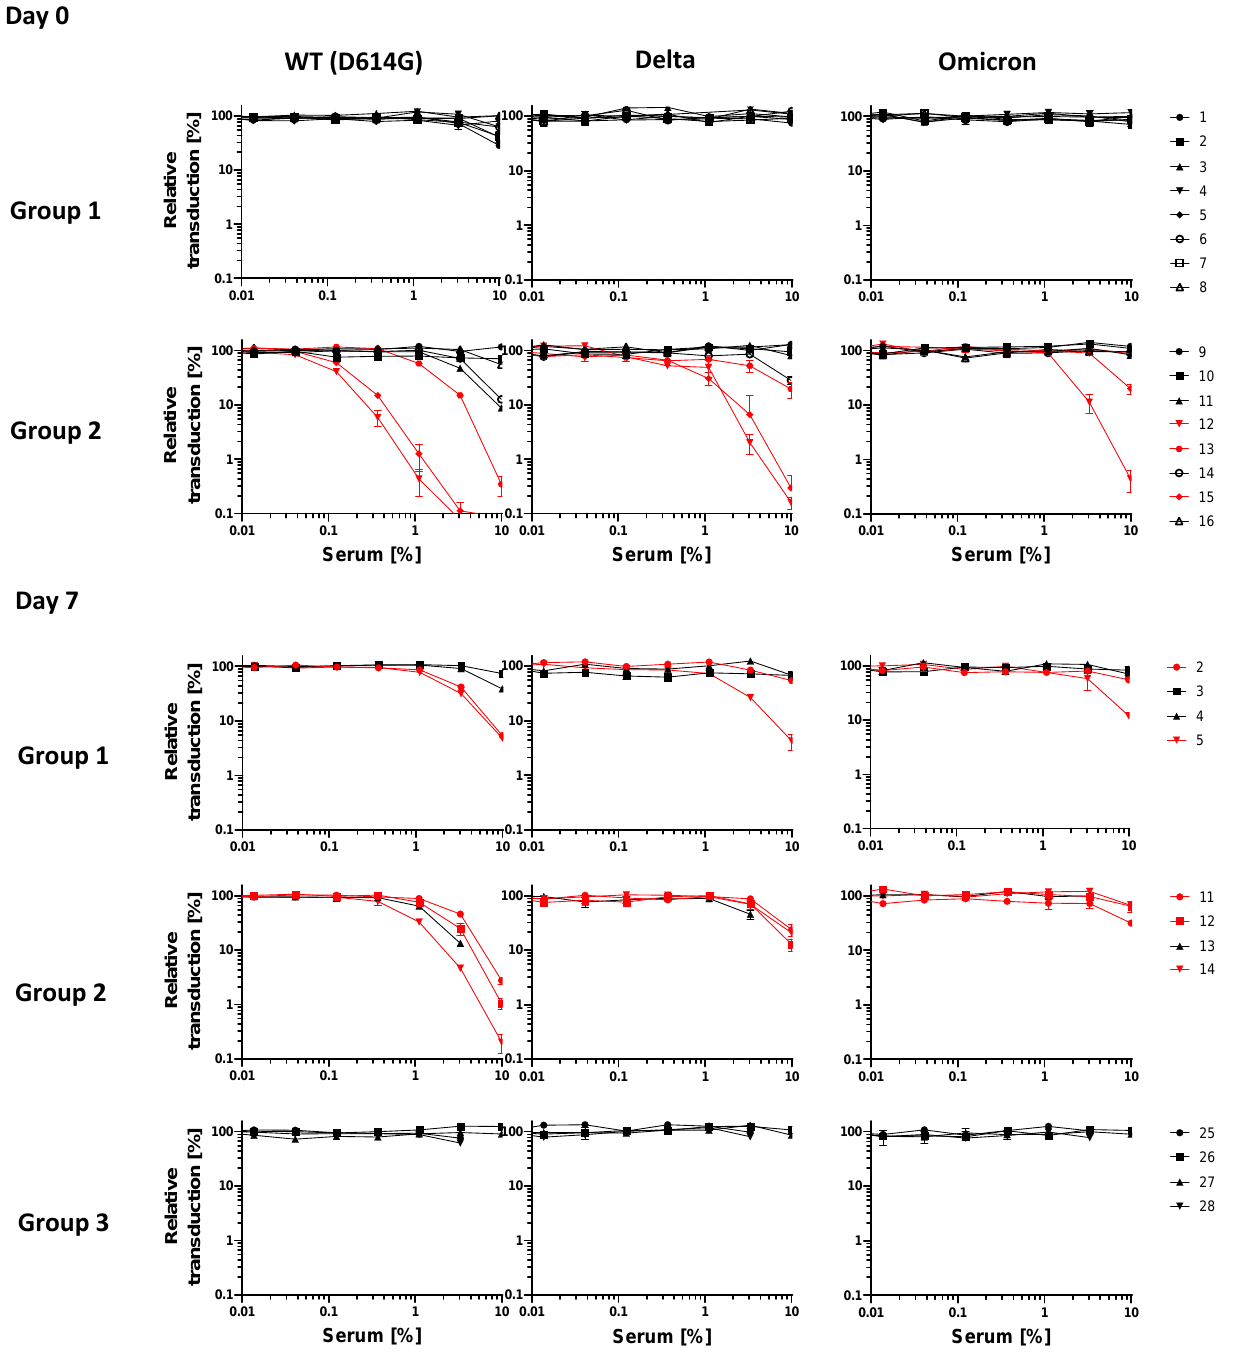
Figure 3. Dose–response curve representing the neutralization activity of plasma against SARS-CoV-2 pseudovirus carrying the spike protein of WT (D614G) virus or variants (Delta and Omicron). The sera analyzed were collected on day 0 (challenge) and day 7 (termination) from vaccinated and unvaccinated ferrets. On day 0, plasma samples from prime-vaccinated ferrets (group 1) were unable to neutralize any viral strains, although minimal activity against the D614G strain was ob- served in three ferrets (Table 1).